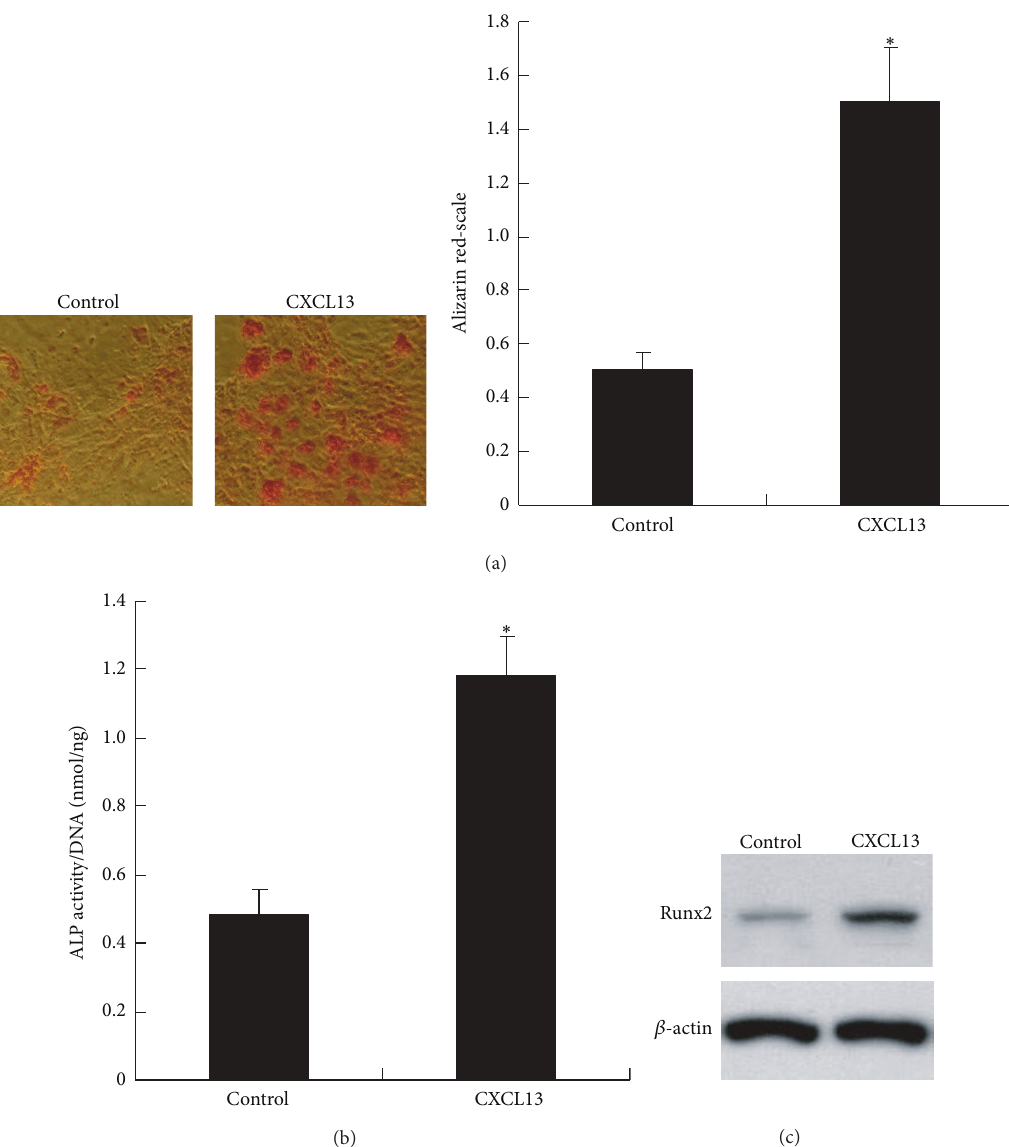
Figure 1: Stimulation of osteogenic differentiation of mesenchymal stem cells by CXCL13. Mouse bone marrow mesenchymal stem cells (BMSCs) were incubated in differentiation media with or without recombinant CXCL13 protein (20 ng/mL) and on day 17, the analysis of osteogenesis and protein expression analysis was performed. (a) Representation of calcium nodes by alizarin red staining. (b) ALP activity. (c) Expression of Runx2 using western blot assays. All values represent means ± SD ( 𝑛 = 3 ). ∗ 𝑃 < 0.05 compared with control groups treated without CXCL13 recombinant